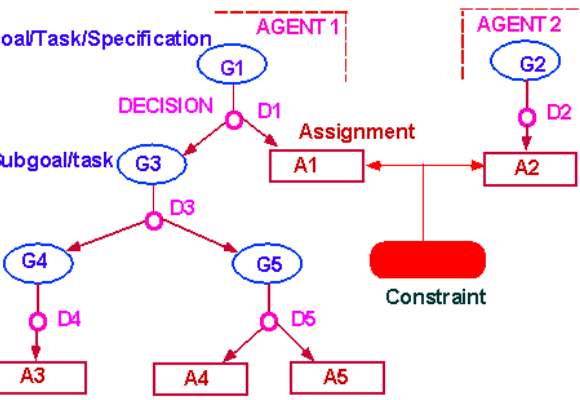
Figure 2. Redux’ Example